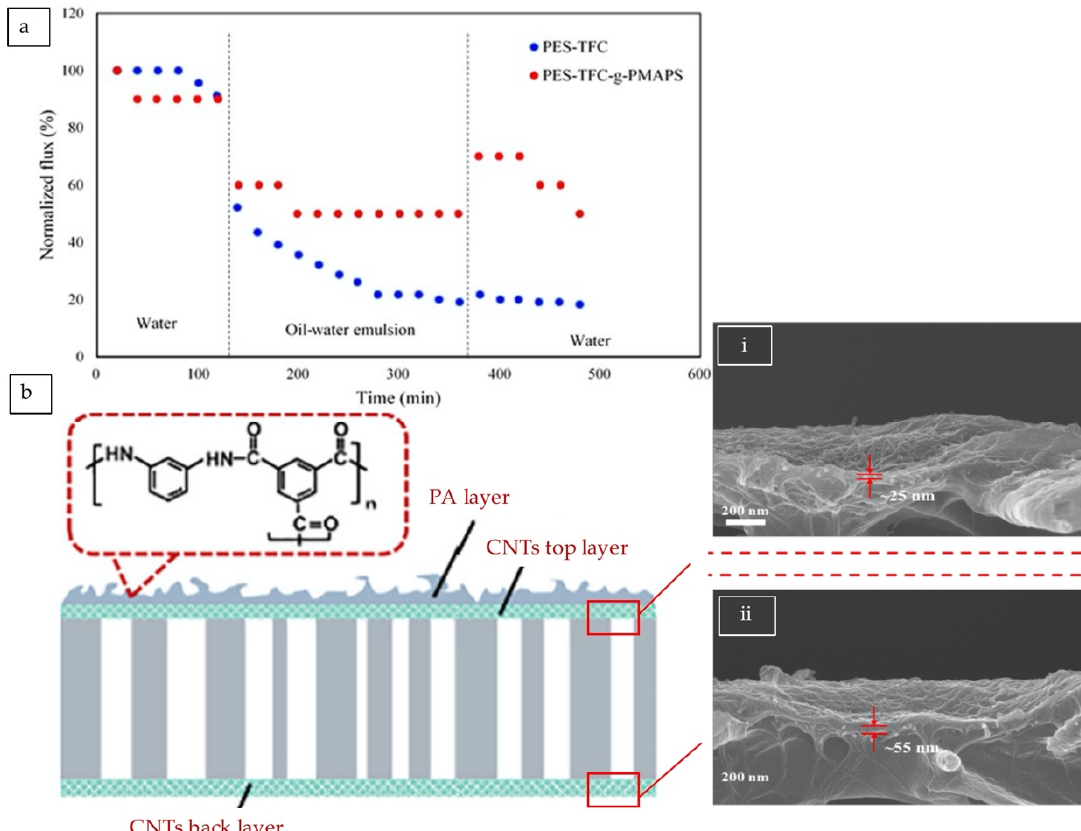
Figure 9. ( a ) Water flux recovery of single-skinned and double-skinned TFC membranes over a period of 480 min [189]. ( b ) Schematic of sandwich-like CNT-PES-CNT with cross-sectional SEM images of (i) CNT top layer and (ii) CNT back layer [31].